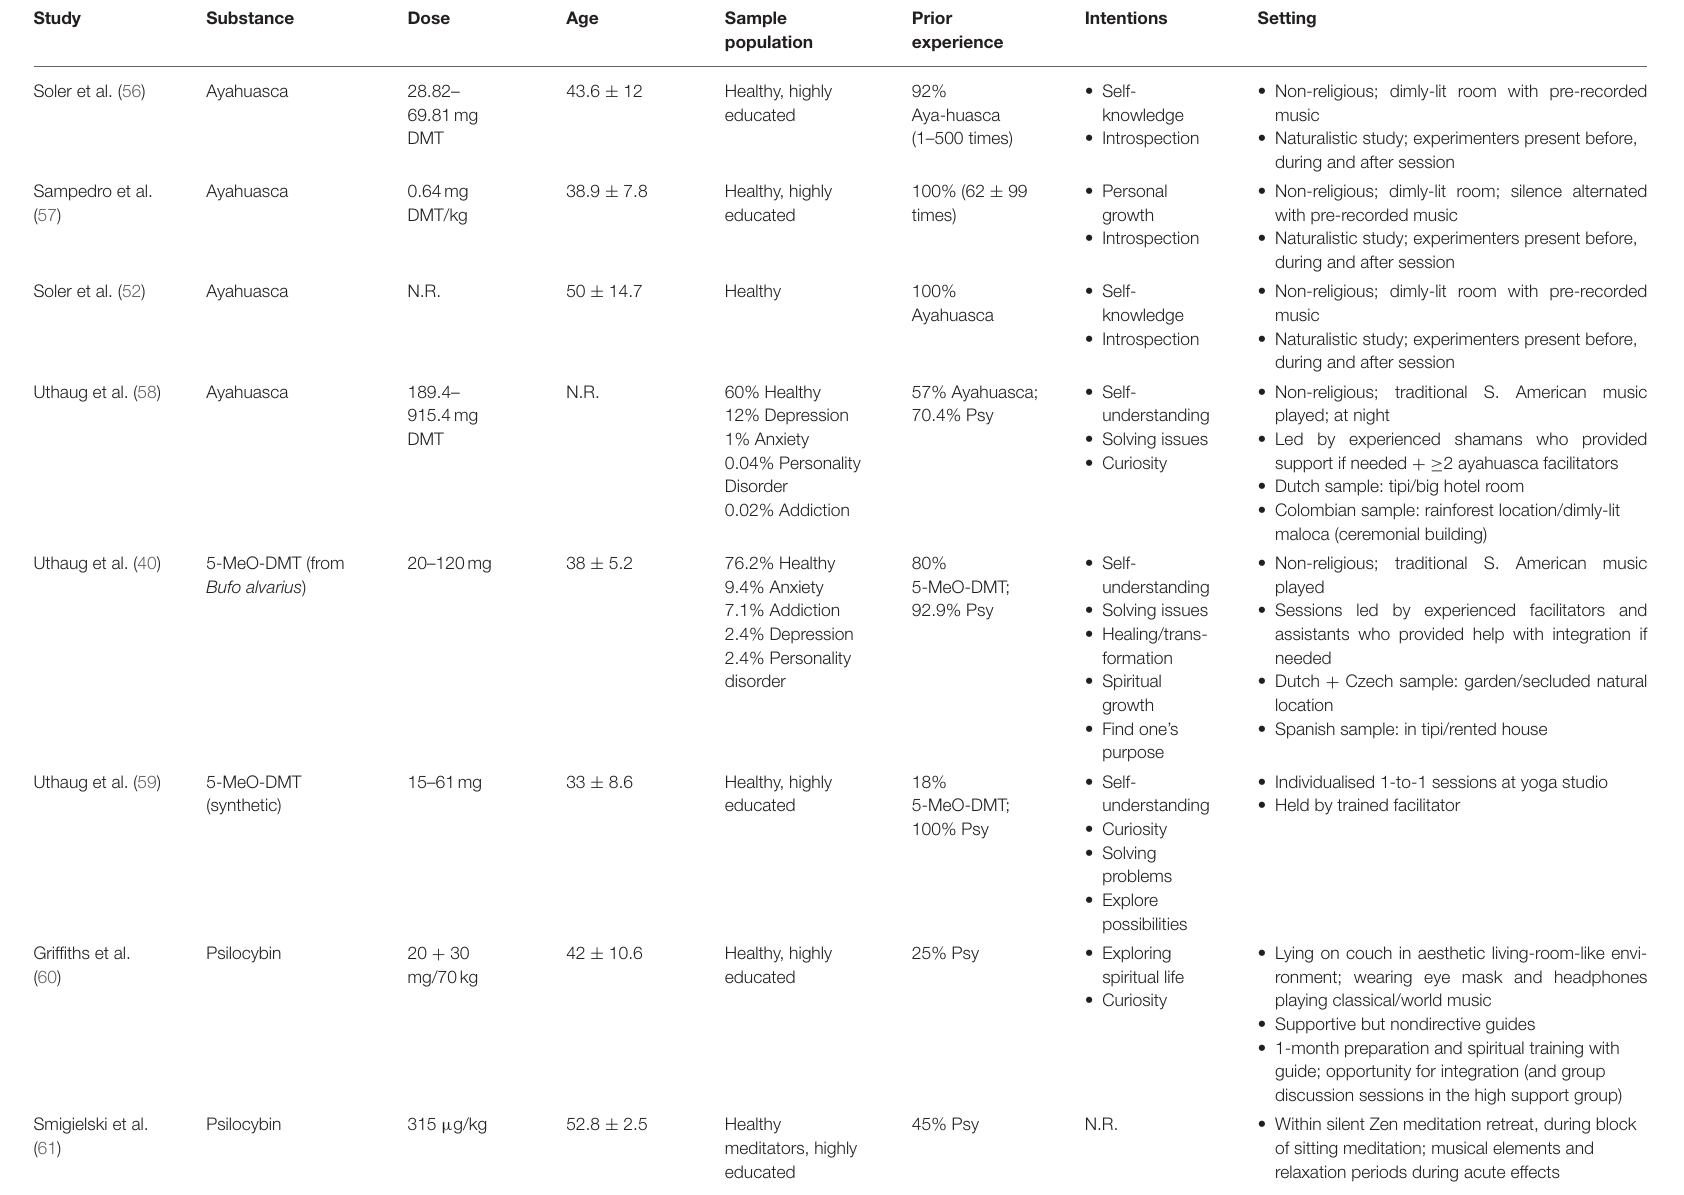
Summary of different participant characteristics and conditions used in the studies reviewed in the main text. For controlled studies, participant characteristics and conditions are listed for the experimental group, where a (active dose of a) psychedelic was administered. Prior experience is listed in terms of percentage of participants who had previous experience with the psychedelic used in the respective study, and also includes percentage of participants with prior experience of other psychedelics (Psy), where the first number is not 100%. (N.R., Not